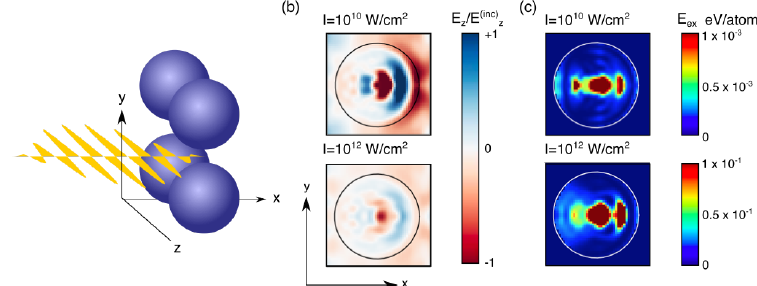
Fig. 2. (a) Schematic illustration of the considered system; a linearly polarized pulsed light irradiate normally on silicon nanospheres that are periodically placed in yz -plane. (b) Electric field 𝐸 O and (c) electron excitation energy 𝐸 P@ ), at 𝑡 =18.4 fs for two incident intensities ( 𝐼 = 10 IM W/cm + and 𝐼 = 10 I+ W/cm +